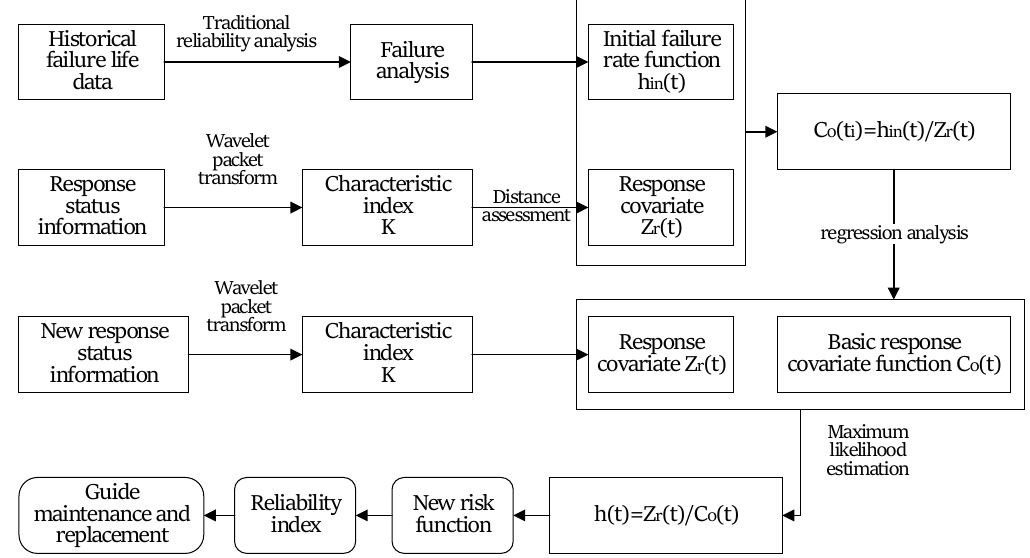
Figure 5. Flow chart of reliability evaluation method based on proportional covariate model.